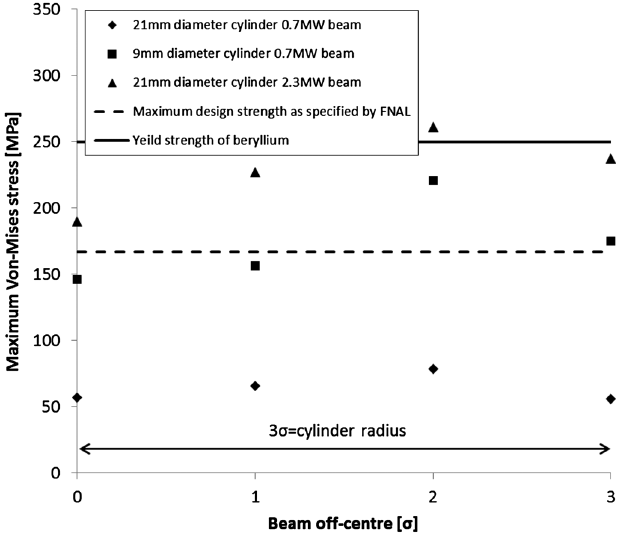
FIG. 1. Maximum Von Mises stress (including thermal and inertial components) in beryllium cylinders as a function of level of